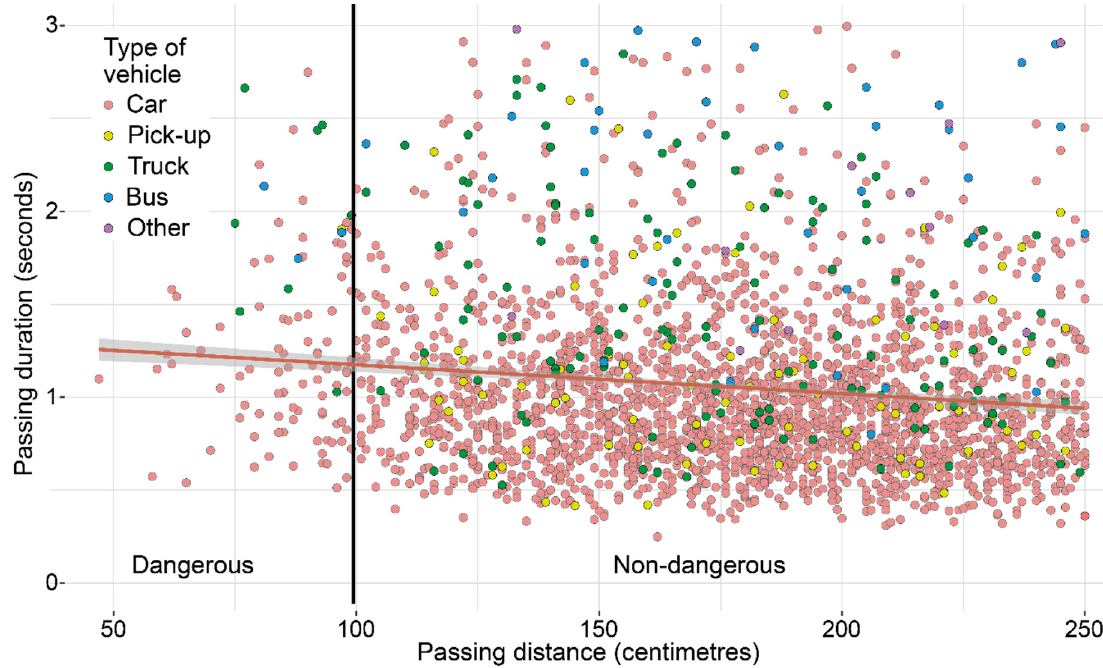
Figure 6. Overtaking in distance (less than 250 cm) and time (less than 3